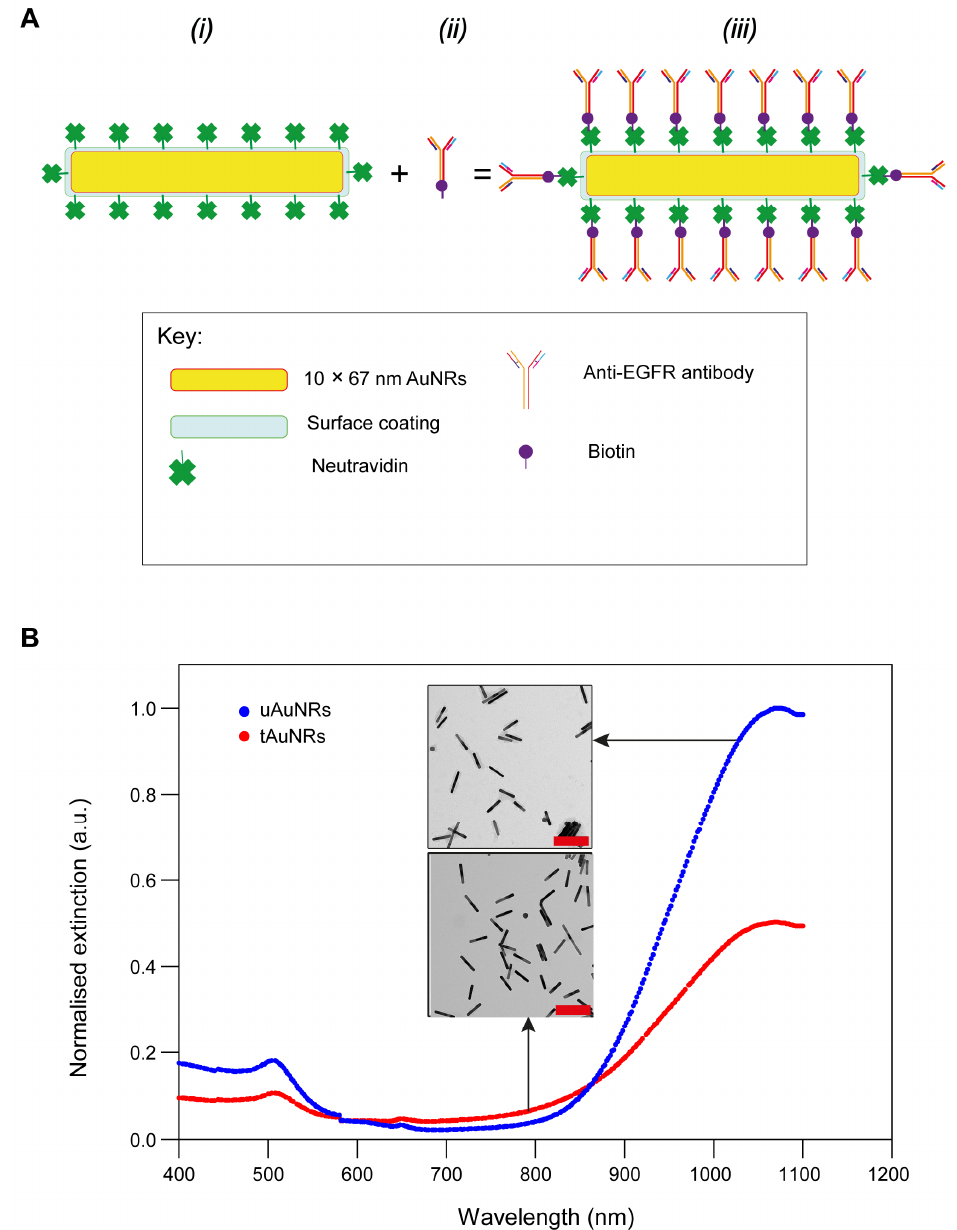
Figure 1. Antibody conjugation process reduced the number of AuNRs. ( A ) Schematic diagram showing a structure of tAuNRs. NeutrAvidin (4 nm × 5 nm × 5.6 nm)-coated10 nm × 67 nm AuNRs ( i ) were added to biotinylated (5.2 nm × 5.2 nm) Anti-EGFR antibody ( ii ) in a 1:2.8 ratio ( v/v ) and conjugated to form tAuNRs ( iii ). ( B ) Absorbance measurement was used to plot the normalised extinction values of targeted and untargeted AuNRs. A loss of 44.3% ± 20.5 of AuNRs in the conjugation process was calculated. TEM images (inset) of uAuNRs and tAuNRs; scale bar (red), 200